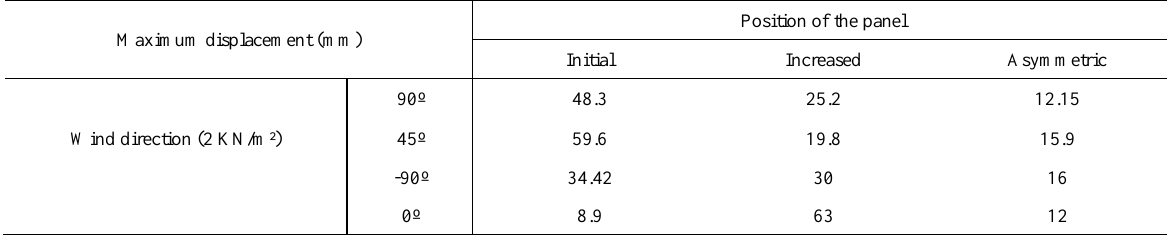
Table 5: Maximum displacement in mm according to wind pressure direction and position of the panel. Glass plate characteristics: thickness: 2.0 mm / dimensions: 1500 x 3000